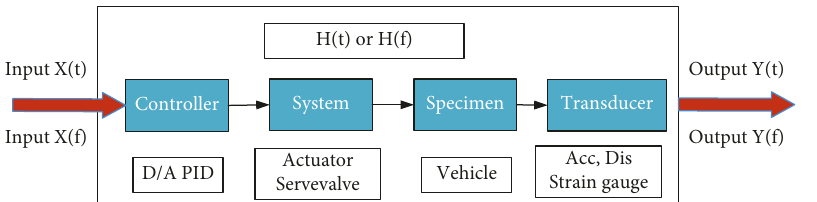
Figure 8: Composition of the testbed.